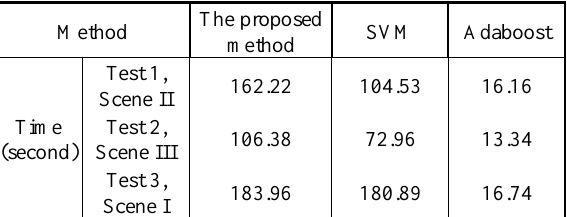
Table 6. The processing time of different